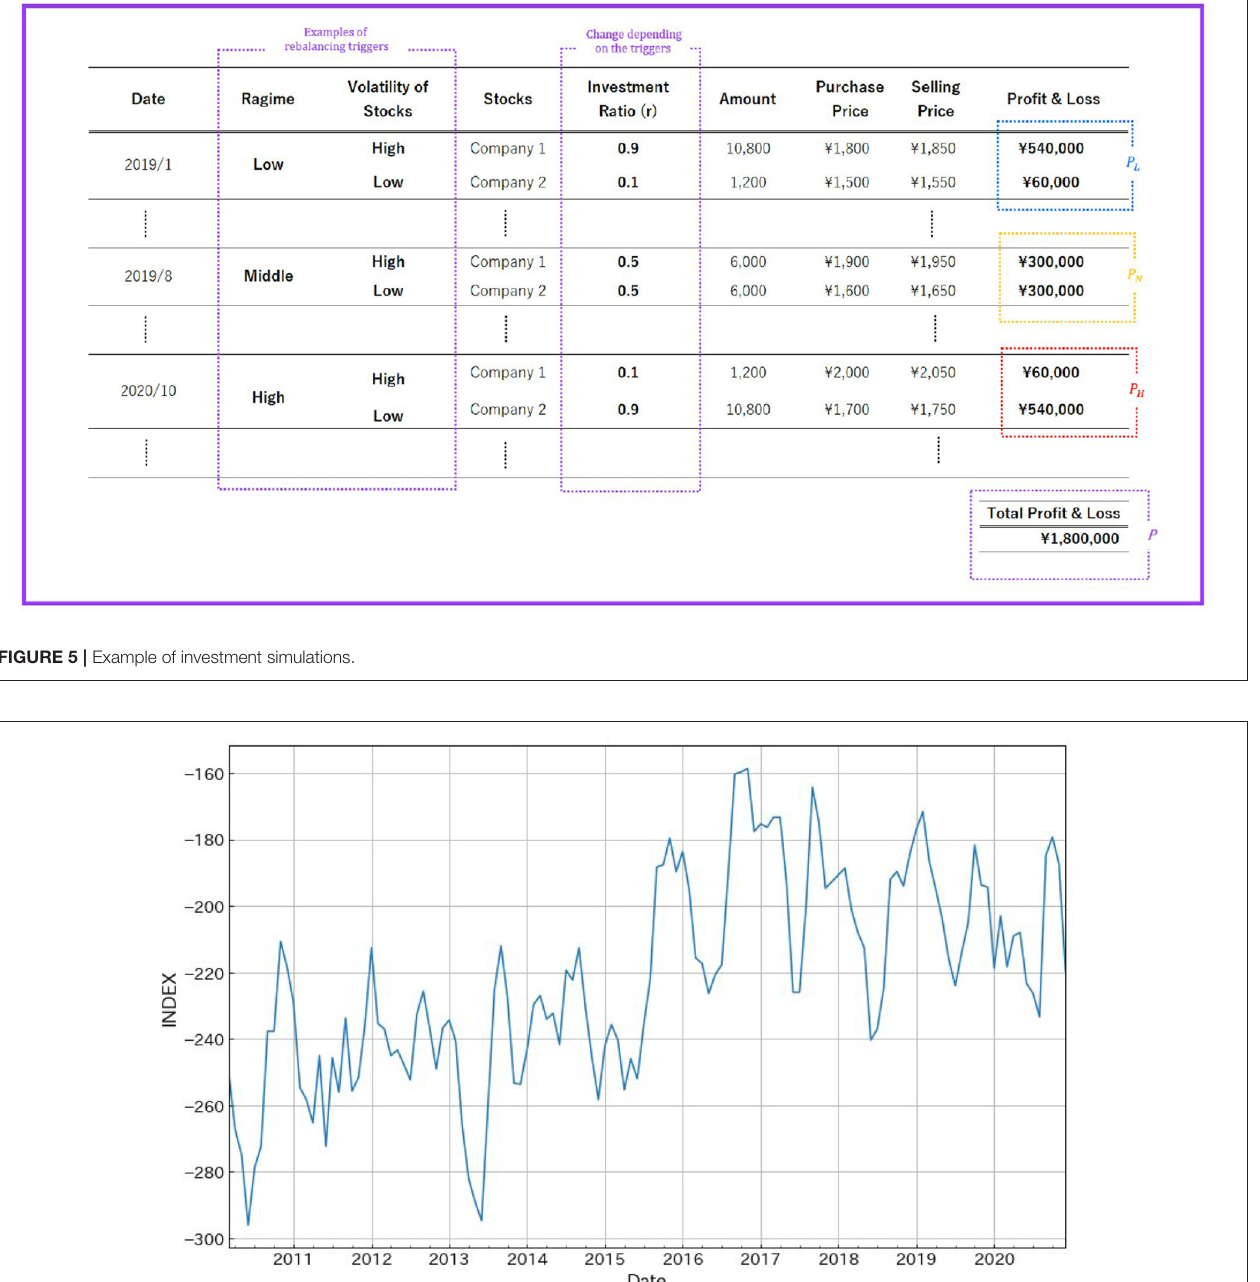
FIGURE 6 | All-industry polarity index with 3-month moving